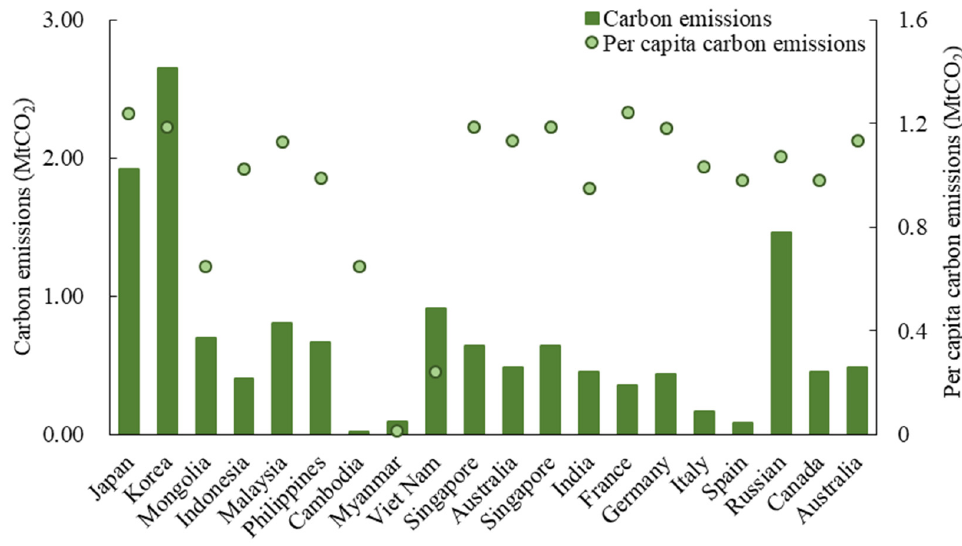
Figure 3. The receiving system carbon emissions of China’s inbound tourism in 2015 (20 main countries are shown).